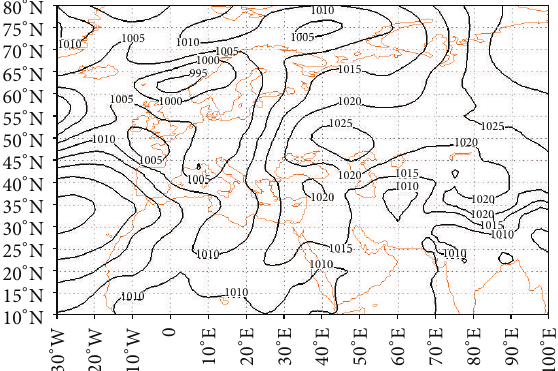
Figure 29: Sea level pressure map in representative day of pattern B. represents the hot period of the year (the first 6 months) with 35% frequency throughout the year. Therefore, this pattern also lacks the precipitation conditions, which is one of the features of this